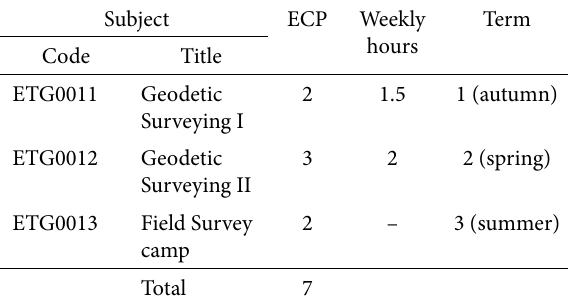
Table 1. Components of the Geodetic Surveying